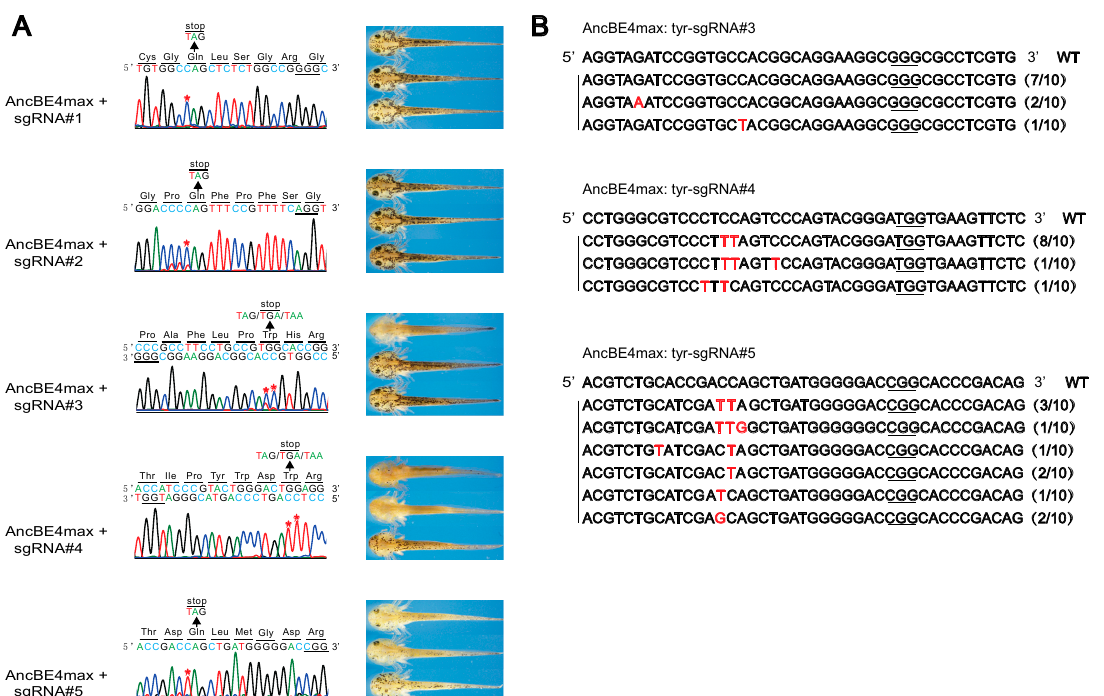
Figure 2. The base editing mediated induction of stop codons (iSTOP) in the tyr gene produces albino animals: ( A ) The genotyping and phenotyping results of the base edited animals. The sequencing chromatograms and the animal pictures showing the base pair conversions created new stop codons (left panels) and varies degrees of albinism (right panels). The asterisks (*) indicate the C-to-T conversions. Scale bar: 2 mm; ( B ) The alignment of the genomic sequence in the base editing region. Ten TA clones were sequenced from one base edited individual and the frequency of each genotype was shown in the parentheses. The base pair conversions are showing in red. The PAM sites were underlined.